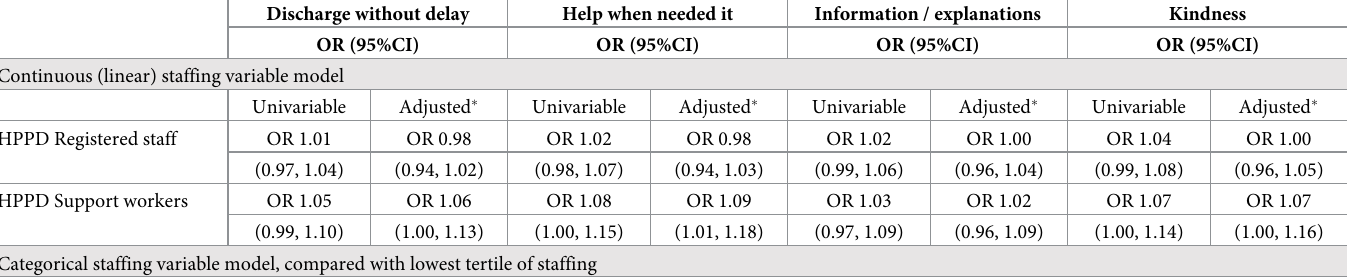
Table 6. Summary of univariable and adjusted regression analysis. Estimated odds of a positive response (analysed by staff recorded on postnatal